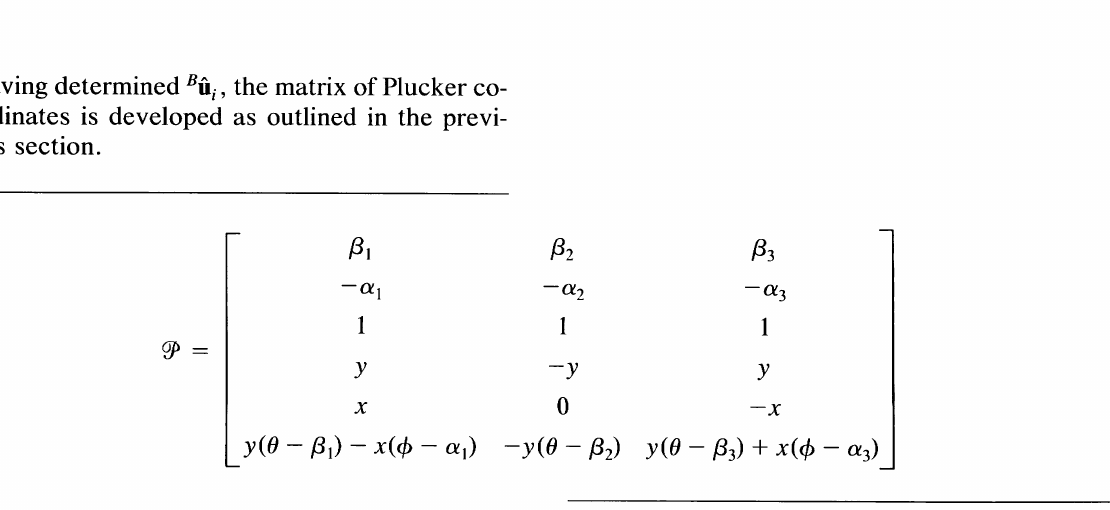
FIGURE 5 Relative displacements of actuator attachment points resulting from arbitrary platform